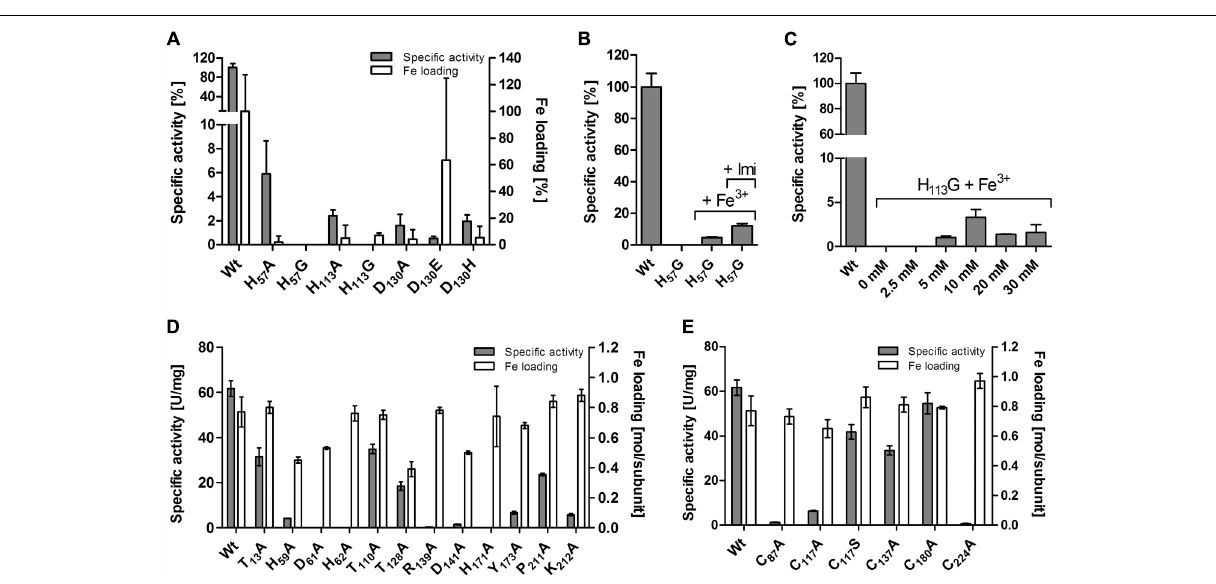
the Ps. putida enzyme (R 190 and K 212 in Ac PDO